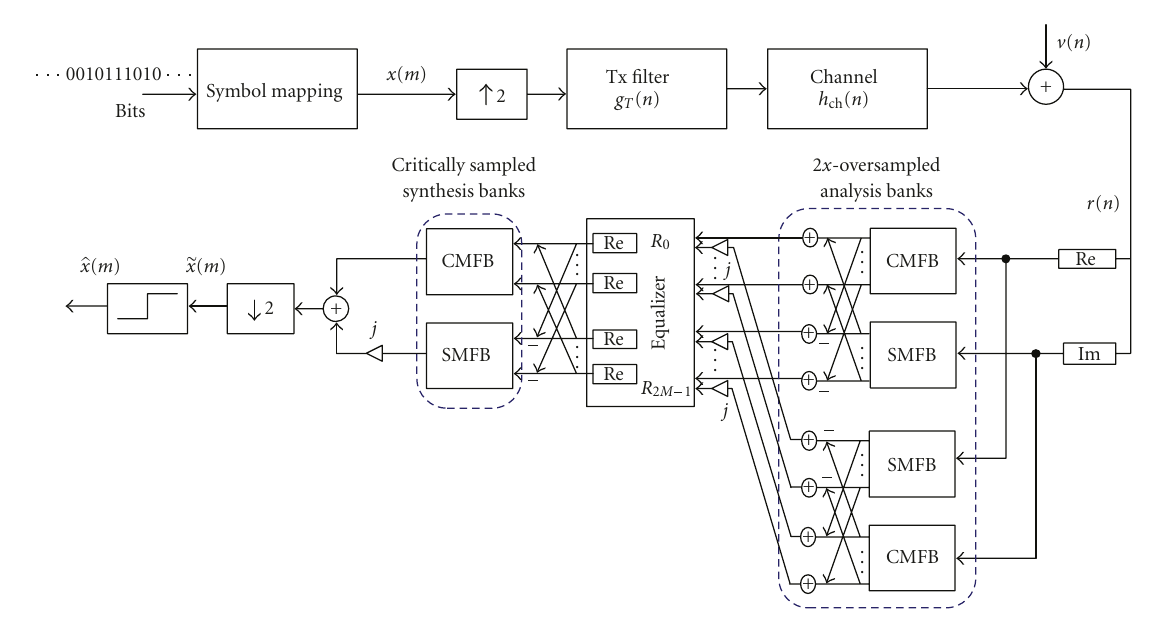
Figure 4: Generic FB-FDE system model in the FSE